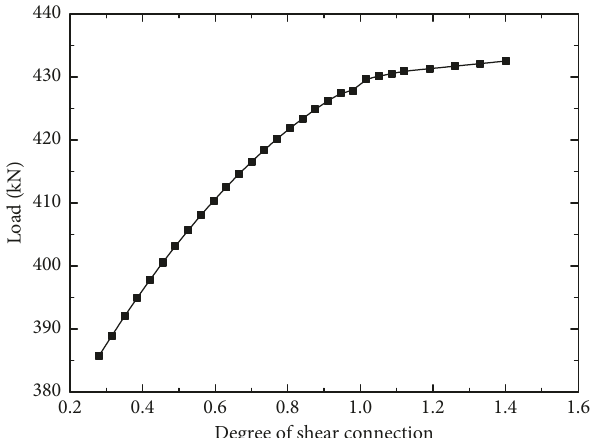
Figure 17: Effect of the degree of the shear connection on the ultimate load.